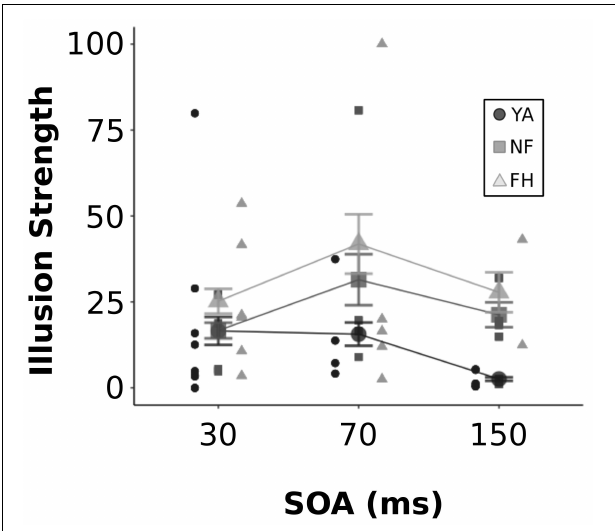
FIGURE 3 | Illusion strength across SOA levels. Individual and group-averaged estimates of illusion strength are displayed for each SOA value. YA adults are represented by black circles, NF by dark gray squares, FH by light gray triangles. Error bars reflect standard error.